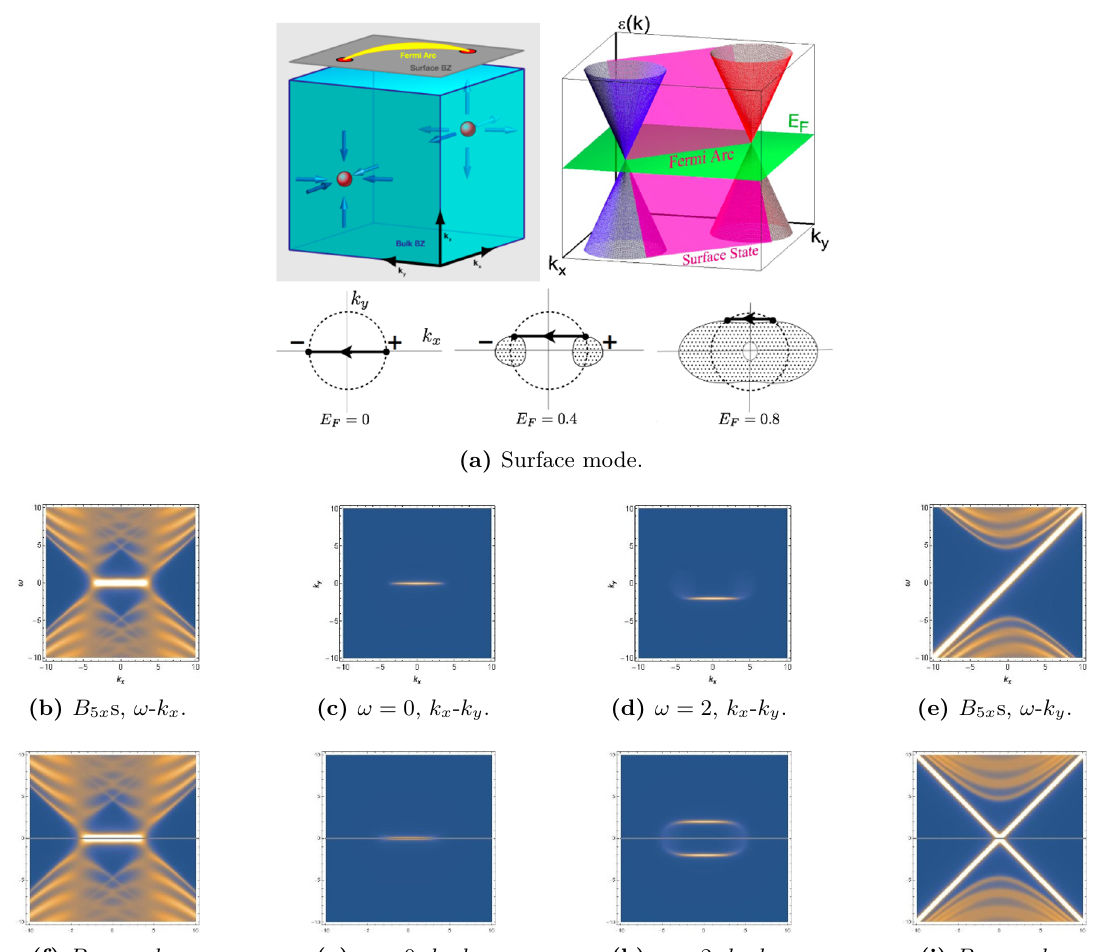
Figure 6. (a)up-left: surface Brillouine zone and Fermi-arc for Weyl-metal. This corresponds to our 1-flavor theory. (a)up-right: bulk spectrum with split cones and ‘surface state’, which is the zero mode. The figure came from [38]. Figures (b,c,d,e) are for our spectral functions (SF) for 1-flavor theory with B 5 x order. Figures (f,g,h,i) are for SF for 2-flavor theory. In figures (d,h), two circles representing the sections of cones are so dim that only arc lines are